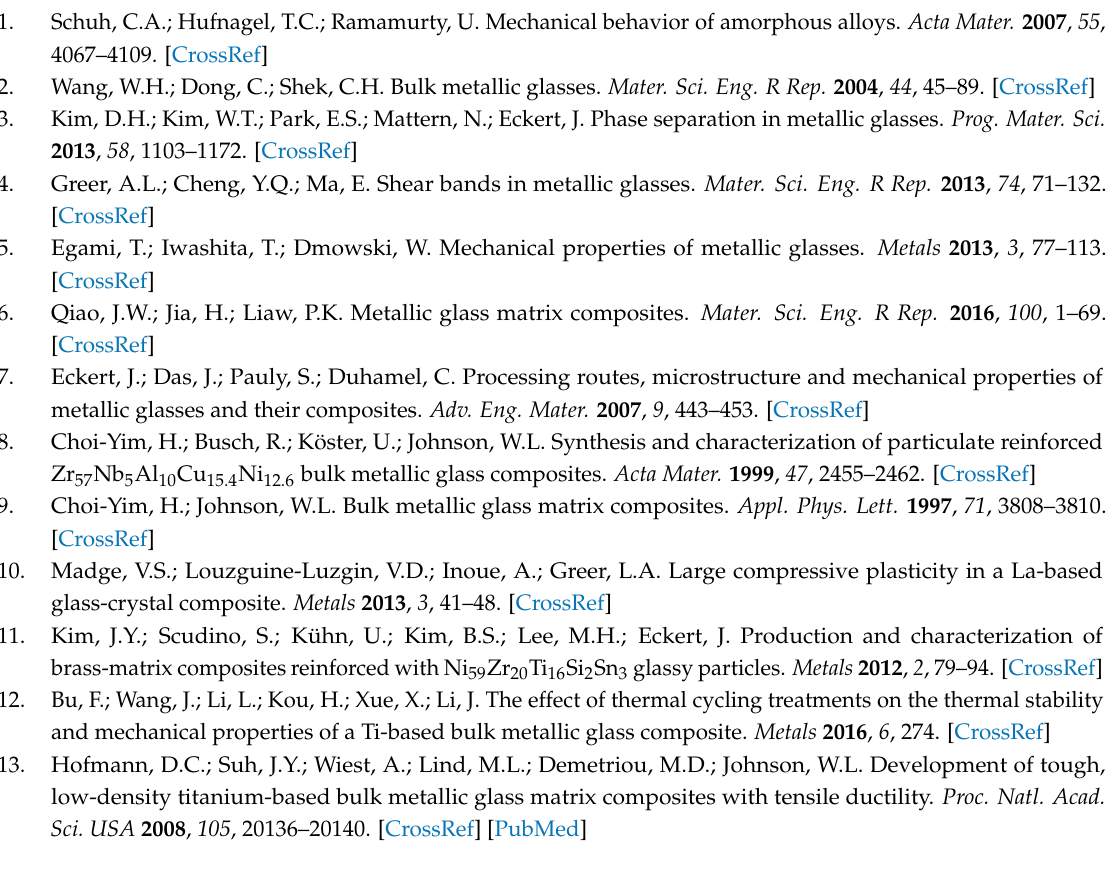
Figure S1: (a) XRD pattern, (b) OM image, and (c) room temperature engineering stress-strain curves of the as-cast T5 samples under compression; Figure S2: (a) the surface morphology and (b–d) the fracture morphology of the as-cast T5 samples under